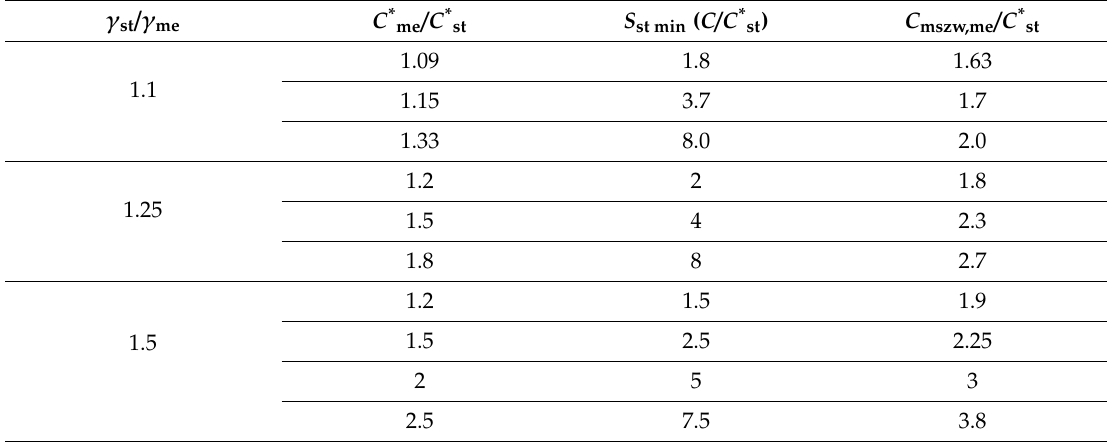
Table 1. Comparison of Estimated Metastable Zone Width for the Metastable Polymorph and the